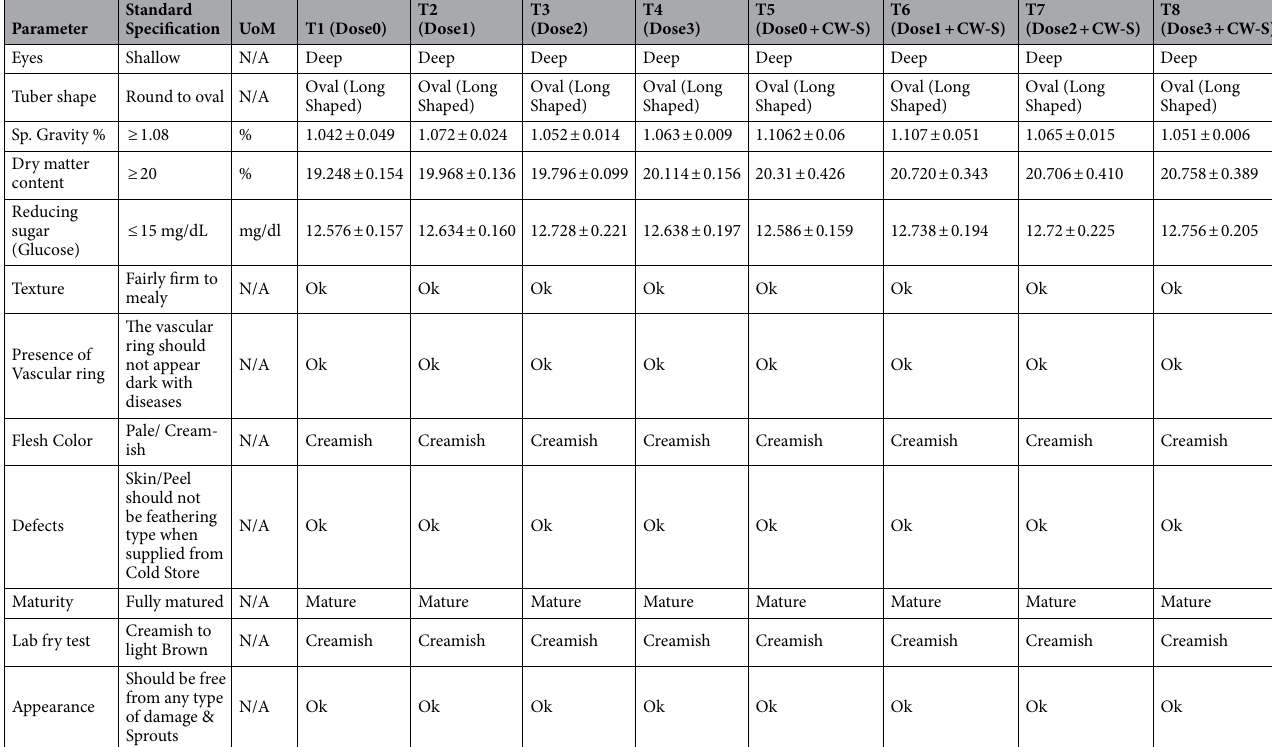
5. An assessment of the industrial parameters of potatoes grown with CW-S. Tuber Temperature = 27.40 °C = 81.32 °F. Defect = 00% Test Report (In loading Point): R/S = x mg/dl, DMC =